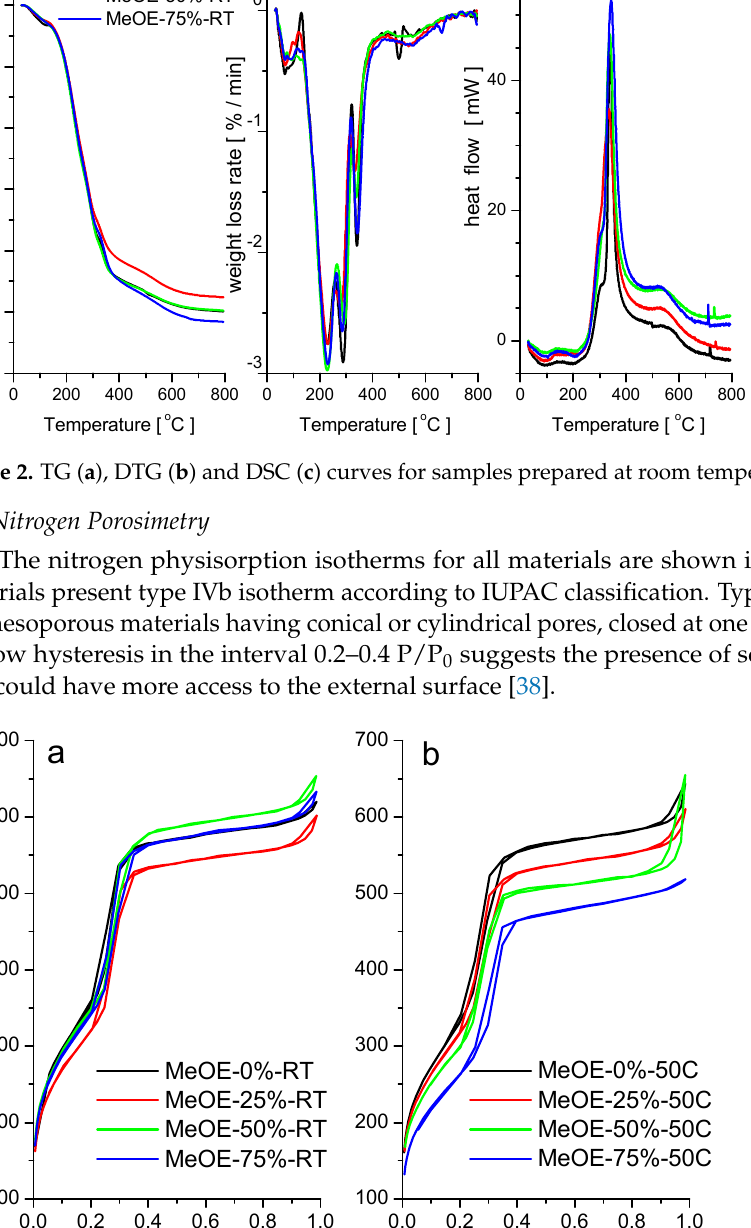
Figure 4. Pore size distribution of samples synthetized at room temperature ( a ) and at 50 °C ( b ). The different texture of the materials was also observed in the surface fractal dimensions evaluated by Frenkel-Halsey-Hill (FHH) method [39]. The FHH model is used 2